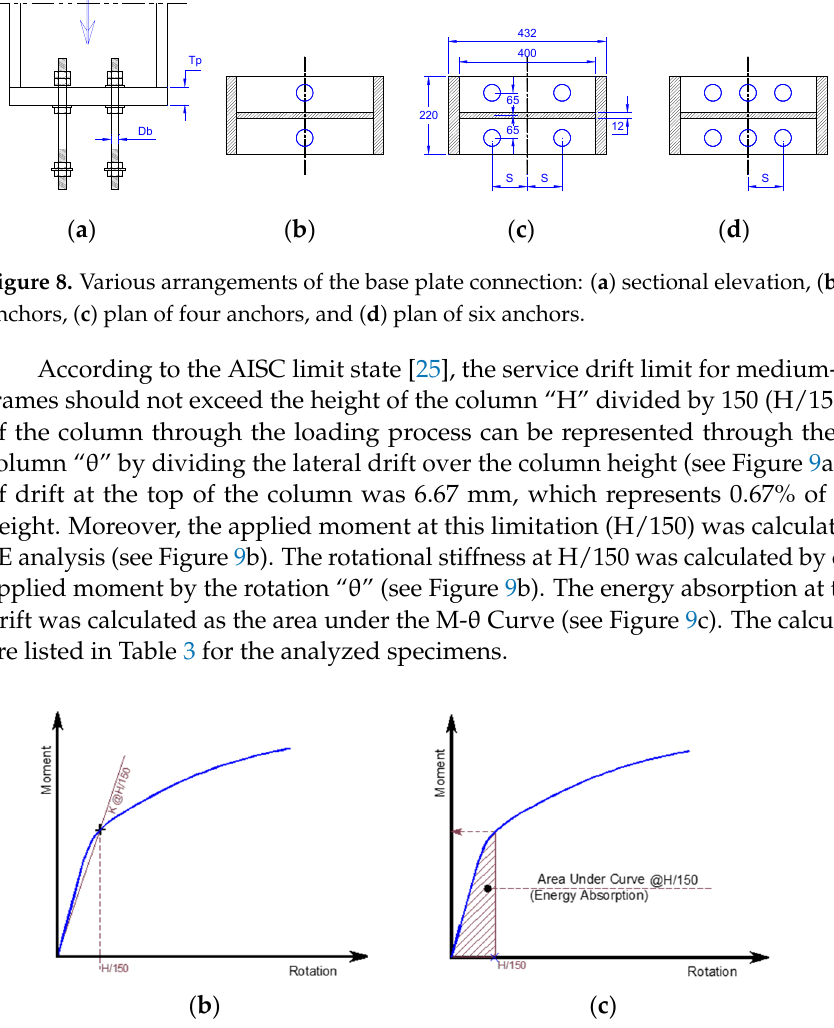
7 of 20 Figure 7. Validation of the second specimen: ( a ) cyclic loading protocol and ( b ) base moment vs. column drift for the FE and experimental results. 3. Parametric Study An extensive parametric study was performed using the validated FE model to provide perfect descriptions and determine the elastic rotational stiffness, moment resistance, and energy absorption of the base plate connections. The parametric study investigated four variables for each specimen: the number of bolts (B), the diameter of anchor bolts (D), the distance between the anchor bolt and the center line of the base plate (S), and the base plate thickness (T). The steel column in each specimen was supported by a reinforced concrete base and under the effect of an eccentric compressive axial load. This effect was represented by axial concentric compressive and lateral loads. Each specimen was labeled with a unique name to cover all studied parameters, i.e., specimen (B4-D18-S050-T24) can be defined as follows: the number 4 in B4 refers to the number of anchor bolts, where the number of anchor bolts varies from two to six, as shown in Figure 8; the number 18 in D18 refers to the anchor bolt diameter in mm, where the anchor bolt diameter varies from 12 mm to 30 mm; the number 050 in S050 refers to the spacing between the anchor bolt and the center line of the base plate (see Figure 8c,d), where the spacing varies from 0 to 150 mm to represent 0%, 25%, 50%, and 75% of half of the steel column depth; the number 24 in T24 refers to the abase plate thickness in mm, which varies from 12 mm to 30 mm. According to the AISC limit state [25], the service drift limit for medium-height steel frames should not exceed the height of the column “H” divided by 150 (H/150). The drift of the column through the loading process can be represented through the rotation of column “ θ ” by dividing the lateral drift over the column height (see Figure 9a). The value